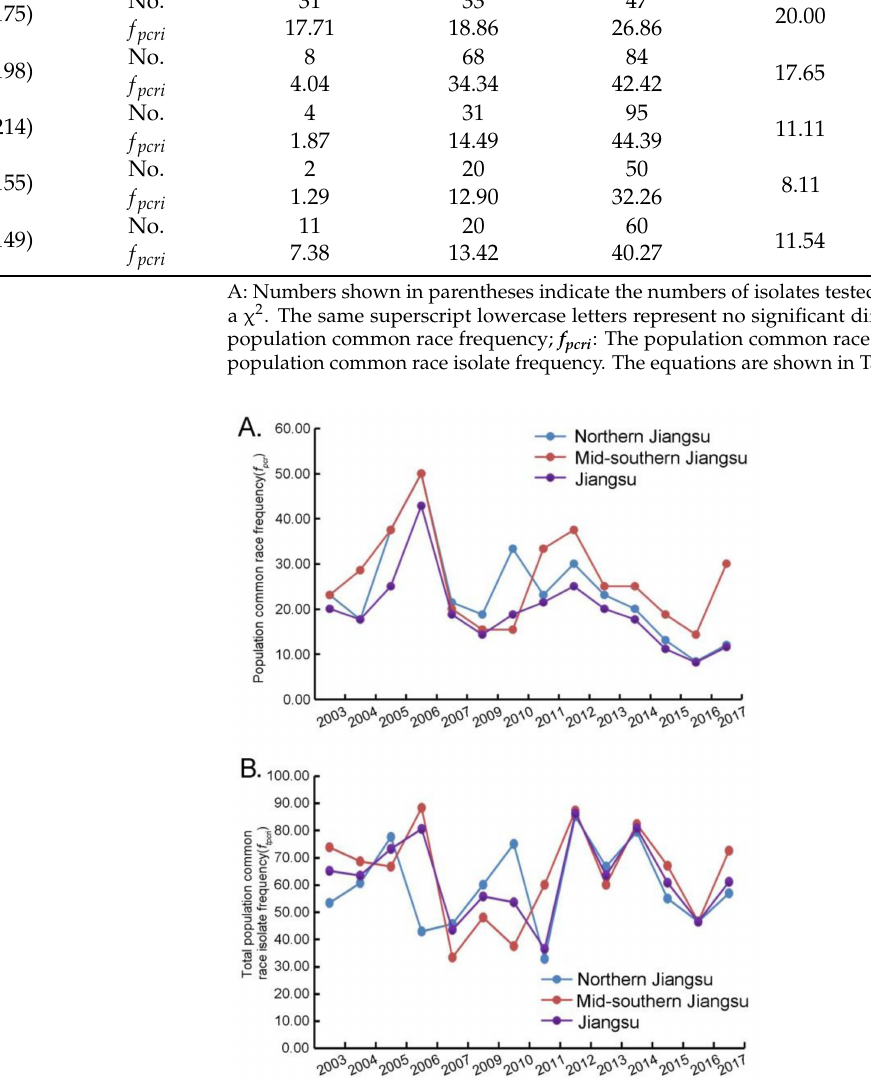
Figure 2. The population common race frequency and total population common race isolate frequency of the P. oryzae in different regions of Jiangsu province from 2003 to 2017. Population common race frequency ( A ). The total population common race isolate frequency ( B ). The blue line represents P. oryzae from northern Jiangsu; the red line represents P. oryzae from mid-southern Jiangsu, and the purple line represents P. oryzae from